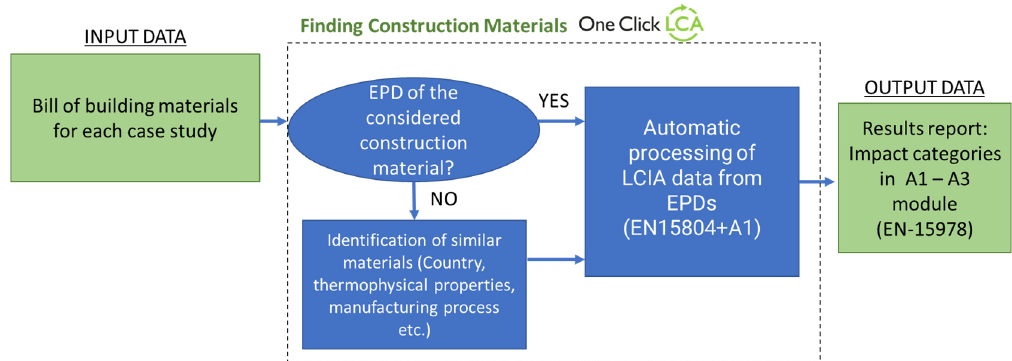
Figure 7. Workflow